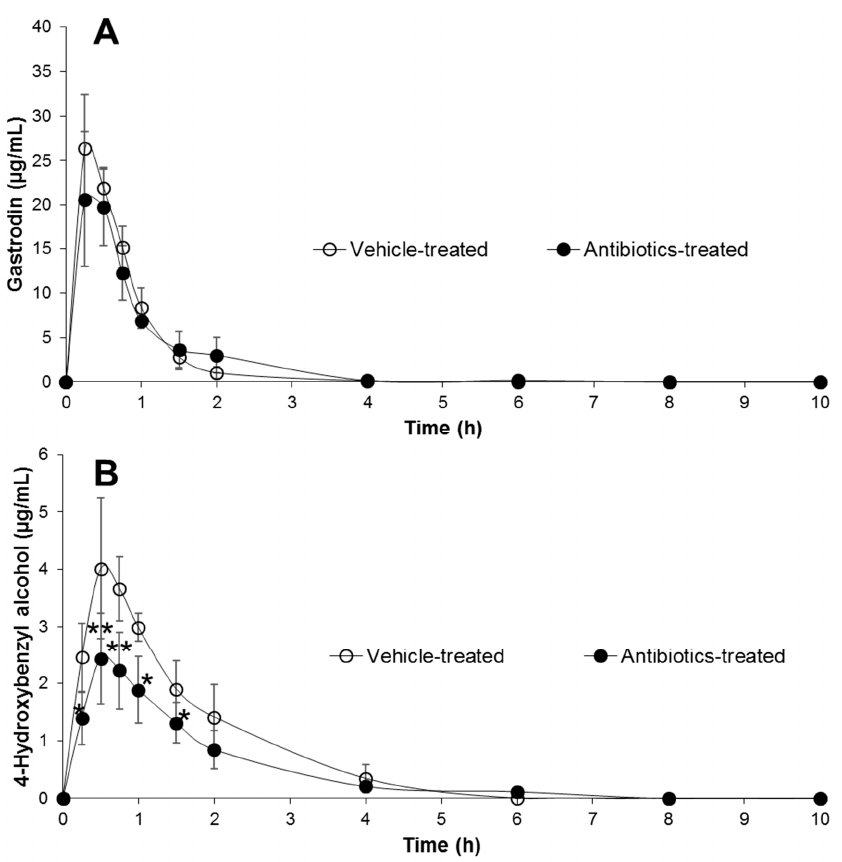
Figure 5. Time course of plasma concentration of gastrodin ( A ) and 4-HBA ( B ) following single oral administration of rats with 40 mg/kg gastrodin in vehicle- and antibiotics-treated rats. Each point represents the mean plasma concentration ± SD of five animals. Asterisks indicate the value significantly different from corresponding controls at either p < 0.05 (*) or p < 0.01 (**).